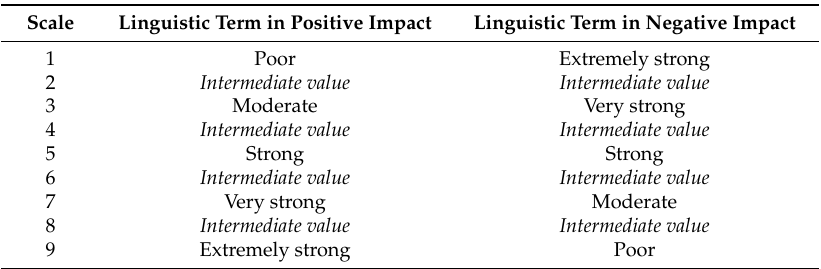
Table 12. Evaluation scores.